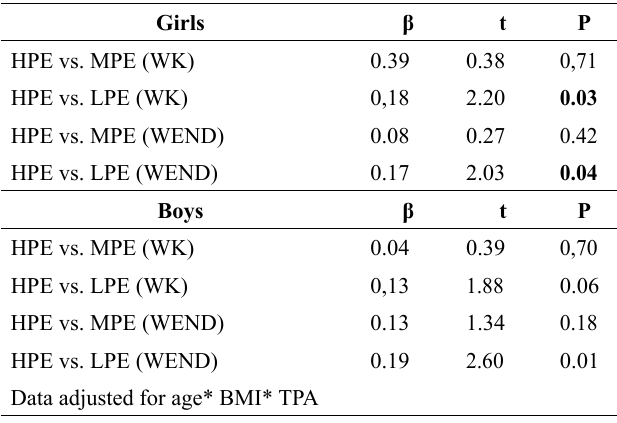
Table 3– Linear Regressions for Girls and Boys at weekdays